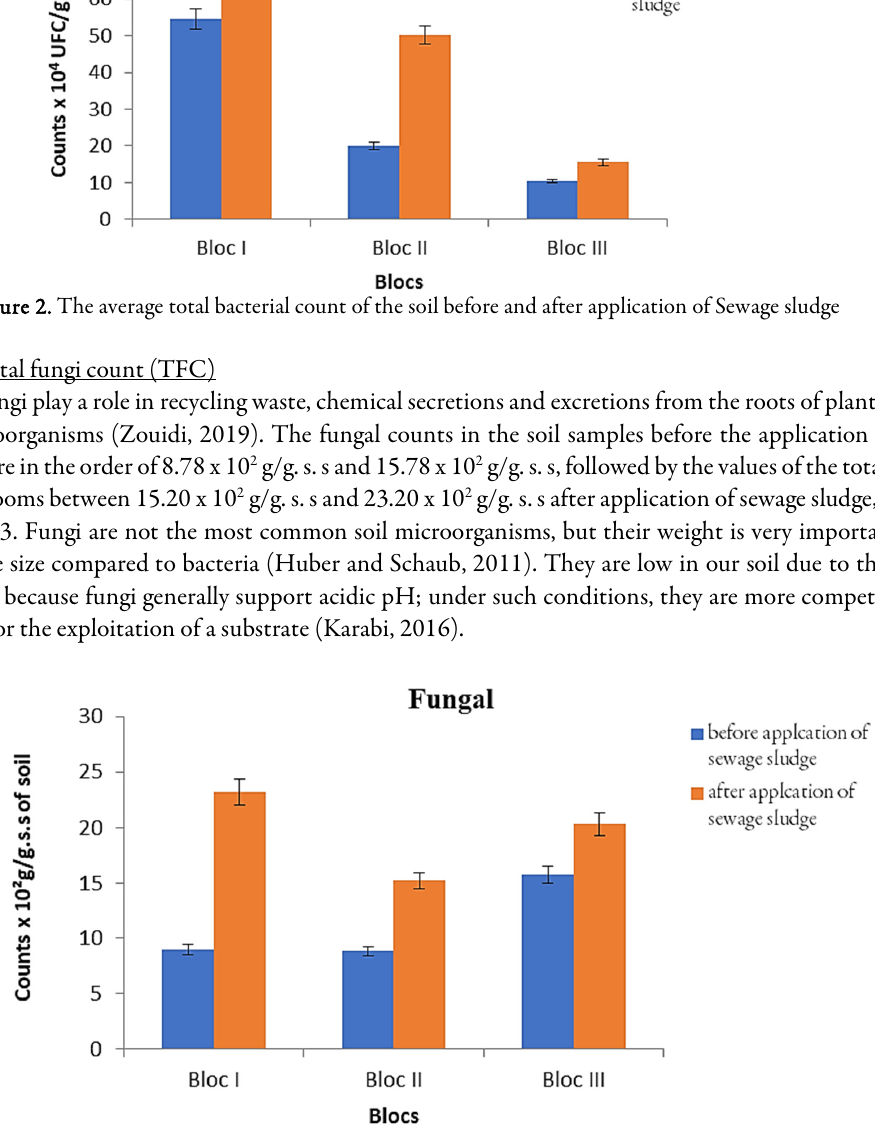
Figure 3. The average total fungi count (TFC) of the soil before and after application of sewage